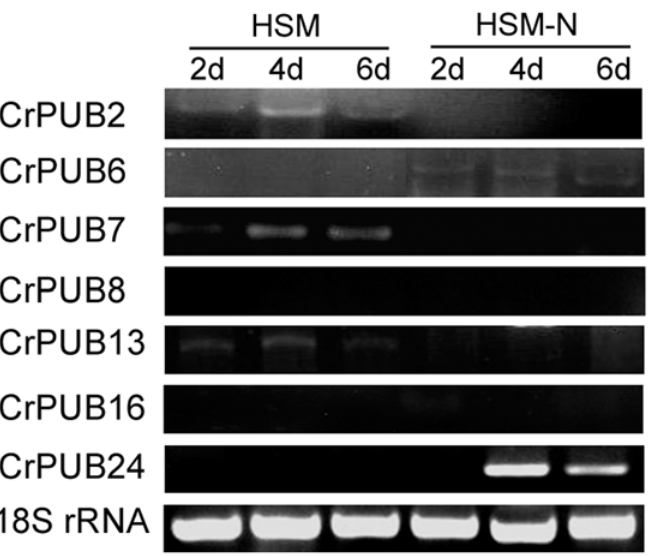
Fig 7. The expression patterns of CrPUB genes as determined by semi-quantitative PCR analyses. Microalgae cells were grown in complete (HSM) and N-starvation (HSM-N) media for 2, 4 and 6 days. Semi- quantitative PCR analyses were performed. The 18S rRNA gene was used as an internal